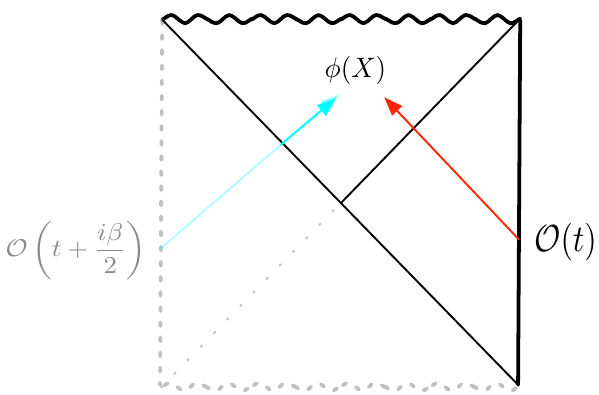
Figure 2 . This (cid:12)gure shows the Penrose diagram for an energy eigenstate black hole in AdS, suggesting the role of ingoing and outgoing modes behind the horizon and their relationship with local CFT operators. Analytic continuation provides a painfully naive but instrumentally e(cid:11)ective method for studying correlators behind the